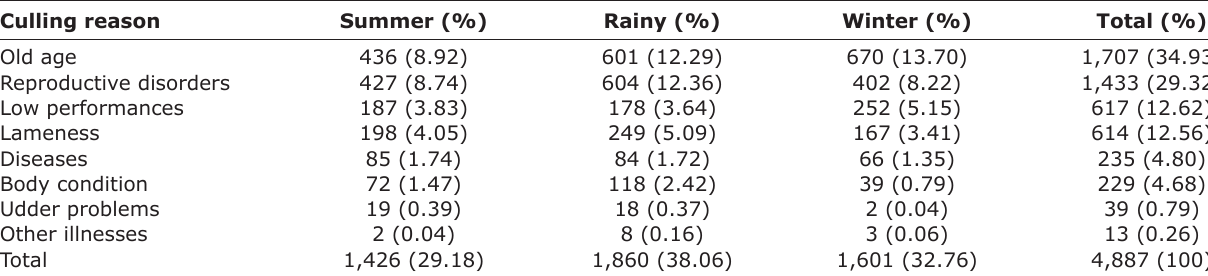
Table-4: The number (percentage) of sow culling by season. Culling